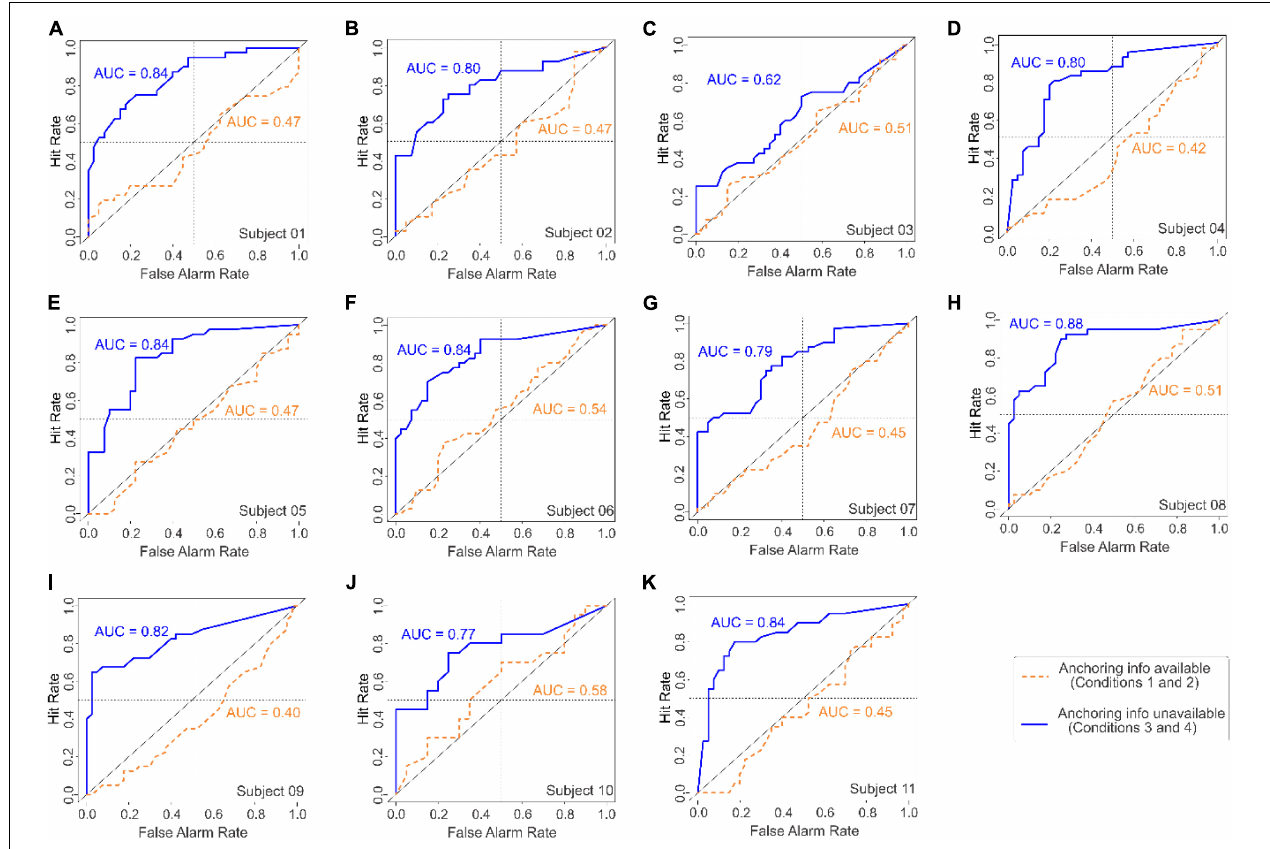
FIGURE 6 | ROC analyses of the responses of each of the 11 individual subjects in Experiment 3 (panels A-K ). In each panel, the ROC curves for Gabor detection performances with or without anchoring information (dashed brown and solid blue curves , respectively) are shown, as are the corresponding AUC values ( brown and blue type, respectively). In each panel, the diagonal represents chance performance (AUC = 0.5). See text for